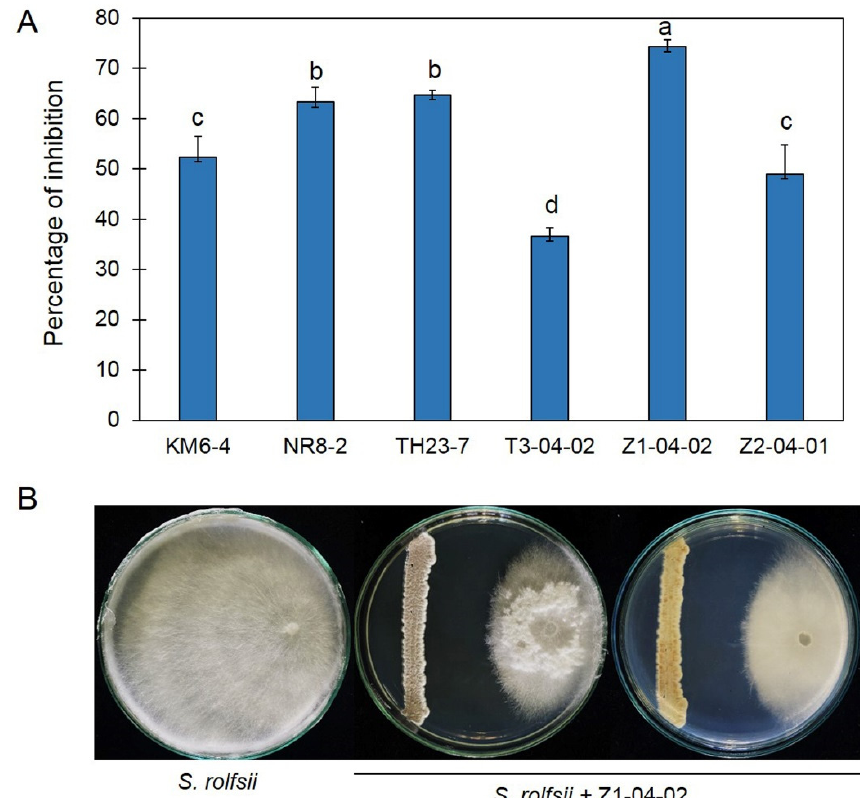
Figure 1. Percentage inhibition of Streptomyces spp. against Sclerotium rolfsii by dual culture assay ( A ); Z1-04-02 effectively inhibited the growth of S. rolfsii in the tested plate ( B ). Data are means ± SD; error bars indicate standard deviation (SD). Different letters indicate significant differences according to Tukey’s test ( p < 0.05).